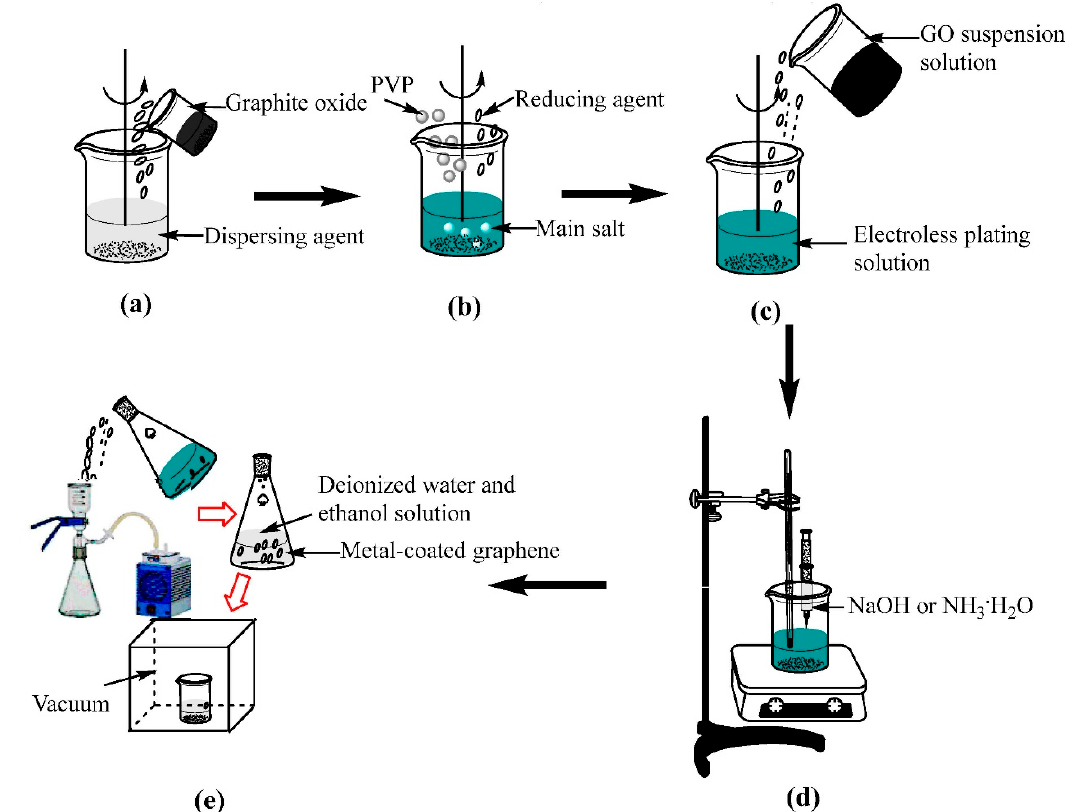
Figure 1. Illustration of the preparation process of Cu@graphene powders and Ni@graphene: ( a ) dispersion of oxidized graphite in dispersing agent; ( b ) electroless plating solution; ( c ) adding GO suspension solution to electroless planting solution and stirred; ( d ) mixture solution was stirred at the same time with dripped NaOH or NH 3 · H 2 O; ( e ) precipitates were filtrated, cleaned and freeze-dried. Table 1. The compositions of metal plating solution (Cu or Ni) and reaction conditions. Plating